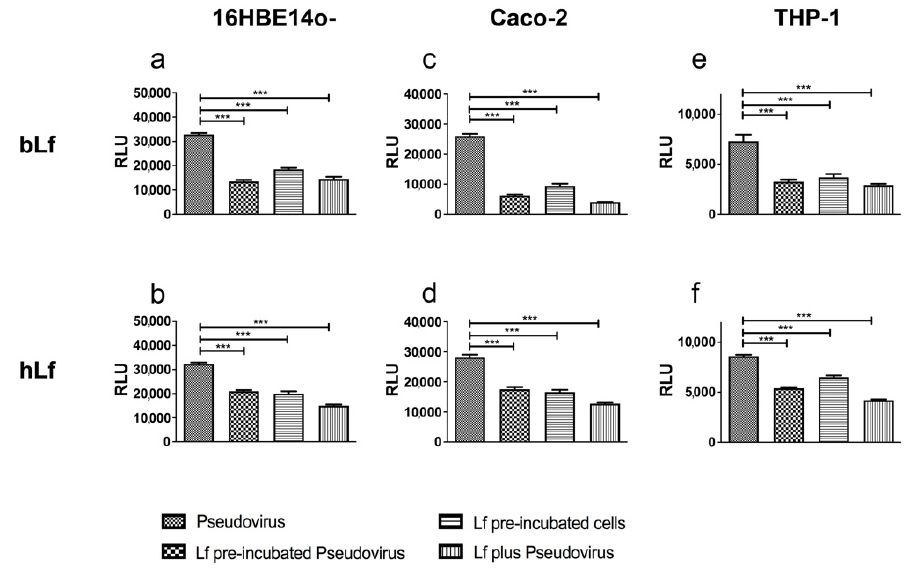
Figure 2. Luminescence of Pseudovirus observed in 16HBE14o- ( a , b ), Caco-2 ( c , d ) and THP-1 ( e , f ) cells infected at multiplicity of infection (MOI) of 10 in the presence or absence of 6.25 µ M of bovine lactoferrin (bLf) ( a , c , e ) or human lactoferrin (hLf) ( b , d , f ). See text for details. Data represent the mean values of three independent experiments. Error bars: standard error of the mean. Statistical significance is indicated as follows: ***: p < 0.001 (one-way ANOVA with post-hoc Tukey test). RLU = Relative Luminescence Units.